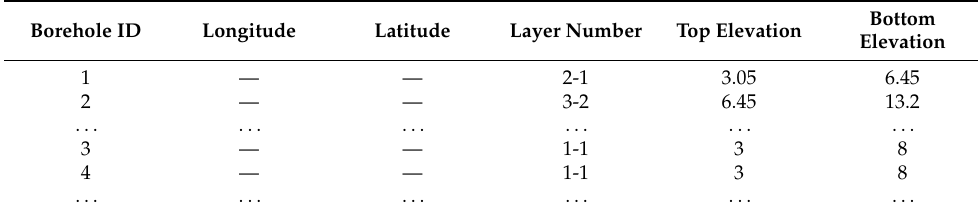
Table 3. Borehole data structure.